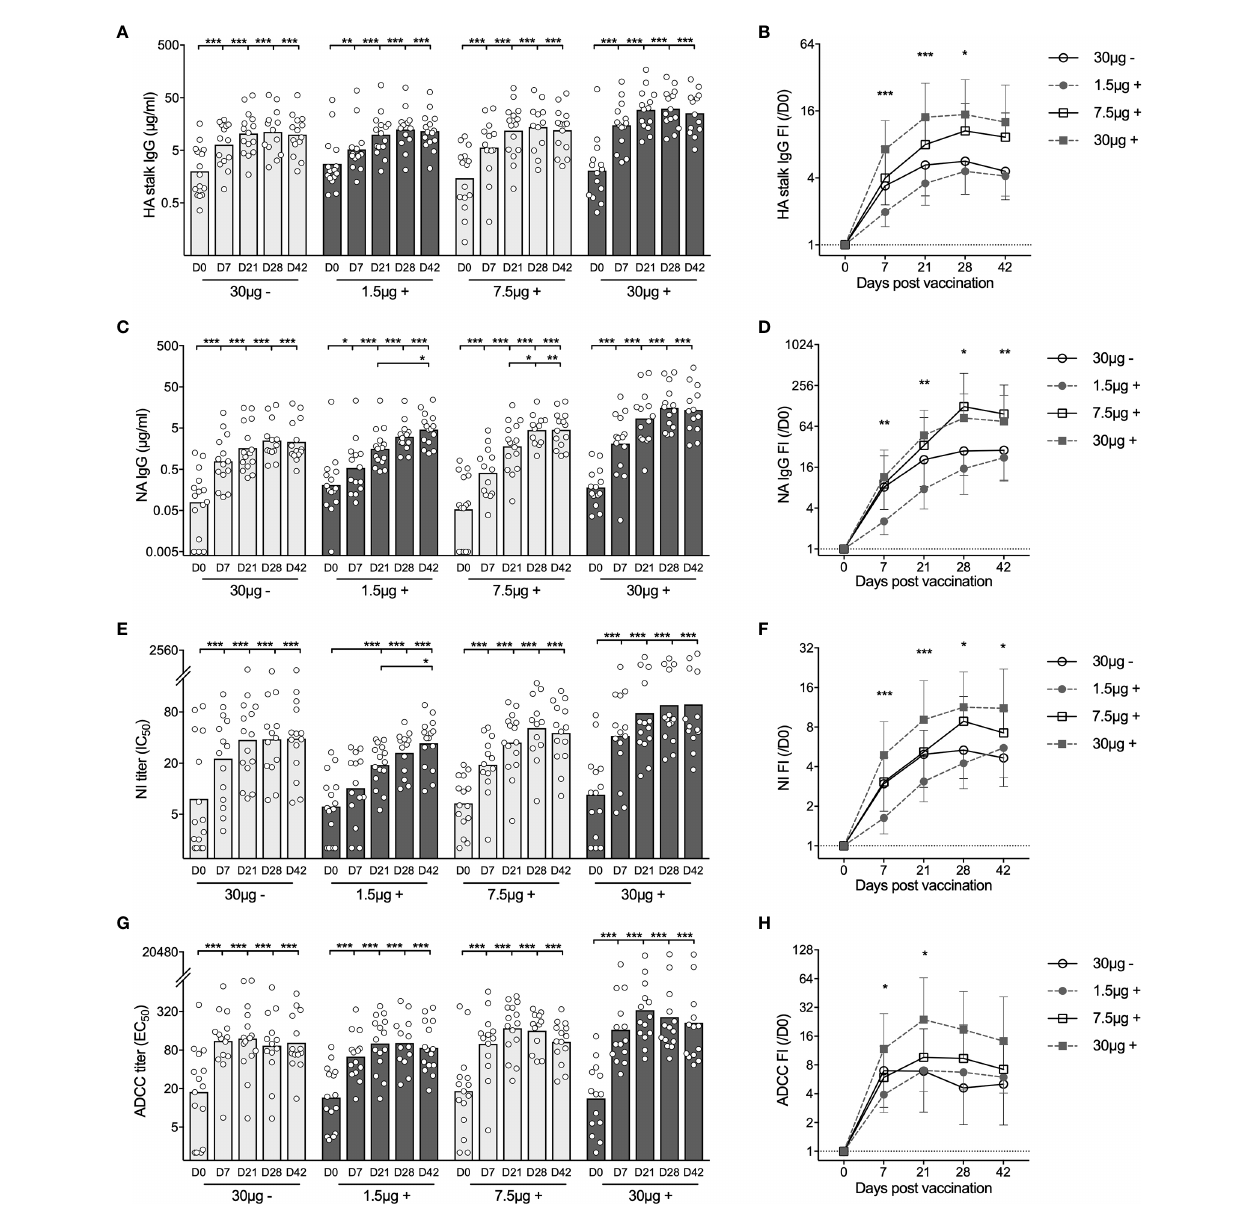
FIGURE 2 | Adjuvanted H5N1 vaccines elicit multifaceted antibody responses. (A, B) H5HA stalk speci fi c antibodies were measured against the recombinant chimeric protein cH9/5HA, which consists of HA stalk domain from H5 A/Vietnam/1203/2004 strain and irrelevant H9HA head domain. Concentrations of total H5HA stalk speci fi c antibody measured in ELISA (A) and fold-induction (FI) after vaccination (IgG FI,/D0, B ) are shown. (C, D) Total neuraminidase (NA) speci fi c antibodies were measured in ELISA against N1NA from A/Vietnam/1203/2004 virus. Antibody concentrations (C) and fold-induction after vaccination (IgG FI,/D0, D ) are shown. (E, F) Pre- and post-vaccination sera were tested for inhibiting NA enzymatic activity in ELLA against reassortant NIBRG-73 virus, which expresses NA from H5N1 vaccine strain and irrelevant H7HA. The neuraminidase enzymatic activity inhibition titer (NI IC50, E ) was calculated as the reciprocal dilutions of the sera that gave 50% inhibition. Fold-induction after vaccination (NI FI,/D0, F ) is shown. (G, H) Sera were tested for inducing antibody-dependent cellular cytotoxicity (ADCC) in ADCC Reporter Bioassay against the vaccine strain (NIBRG-14). The ADCC titer (EC50, G ) was calculated as the reciprocal dilutions of the sera that gave 50% of the maximal biological response. Fold-induction after vaccination (ADCC FI,/D0, H ) is shown. The geometric mean titers are shown as bars, and each symbol represents one subject (A, C, E, G) . The geometric means of fold-induction in each group ± geometric standard deviation as error bar are shown (B, D, F, H) . *P < 0.05, **P < 0.01, ***P < 0.001 (Antibody titers and fold-inductions were Ln transformed in statistical analyses. Turkey ’ s multiple comparisons between pre-prime (D0) and post- prime (D7, D21, D28, D42), and between pre-boost (D21) and post-boost (D28 and D42) in each group were performed in two-way ANOVA in A, C, E, G. Turkey ’ s multiple comparisons between 30 m g + and 1.5 m g + after prime (D7 and D21), and between 30 m g + and 30 m g - after boost (D28 and D42) were performed in two-way ANOVA in B, D, F, H ). The horizontal dotted lines indicate fold-induction of 1 (B, D, F, H) . Duplicates were performed in all